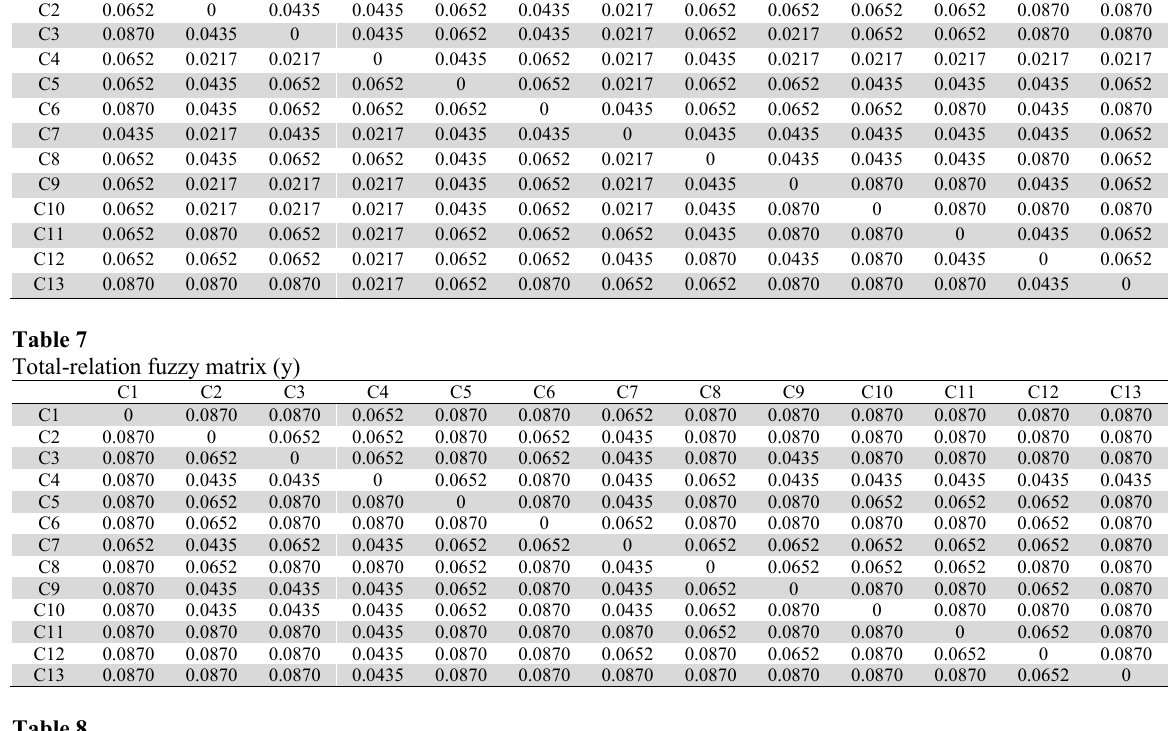
Crisp values Di+Ri and Di-Ri Criteria